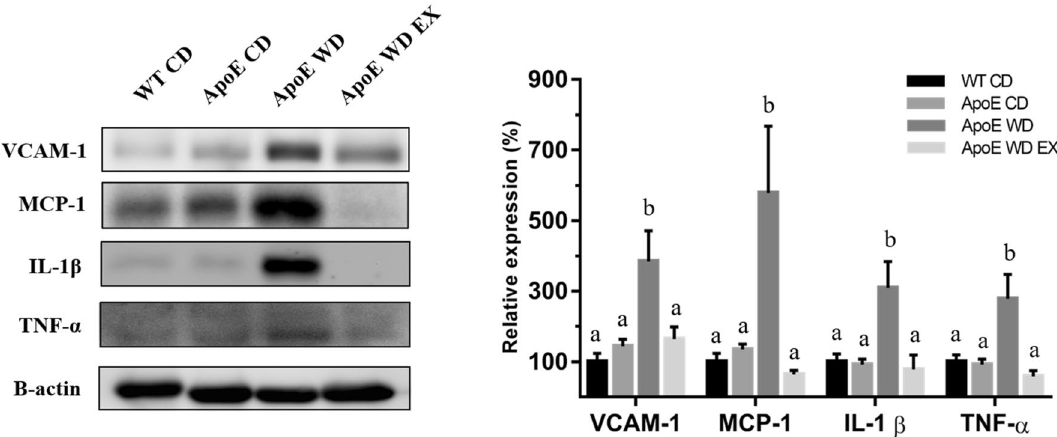
Figure 6. Effects of endurance exercise on aortic chemokine and proinflammatory cytokine expressions. VCAM-1, MCP-1, IL-1β, and TNF-α expression in the aorta was determined through Western blotting. Values are mean ± SEM ( n = 6). Different superscript letters (a and b) indicate significant differences ( P < 0.05) in one- way